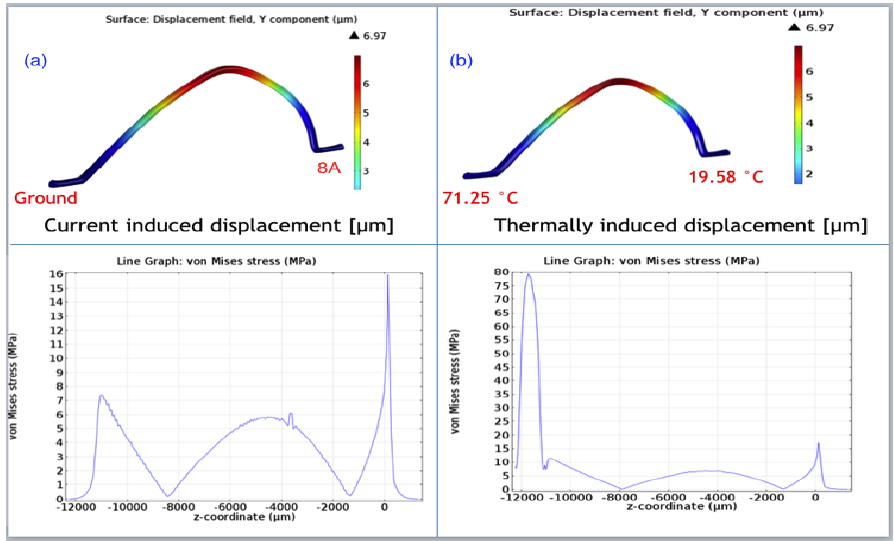
Figure 7. Vertical displacement and von Misses stress along the wire span under ( a ) dc current and ( b ) junction temperature